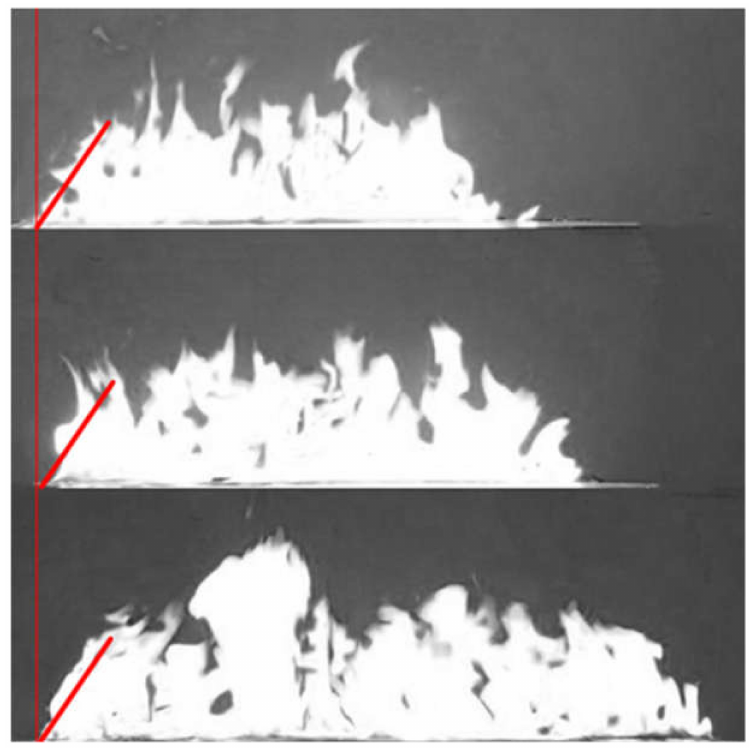
Figure 8. Diagram of the influence of side air entrainment on flame.